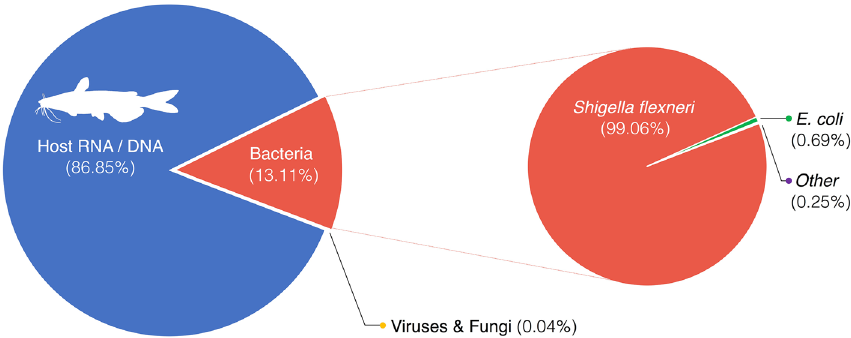
Figure 2. Taxon of the 59,316 reads which were successfully mapped. Host RNA is based on reads that mapped to the genome of yellow catfish. The species breakdown of the reads which mapped to bacterial sequences is also